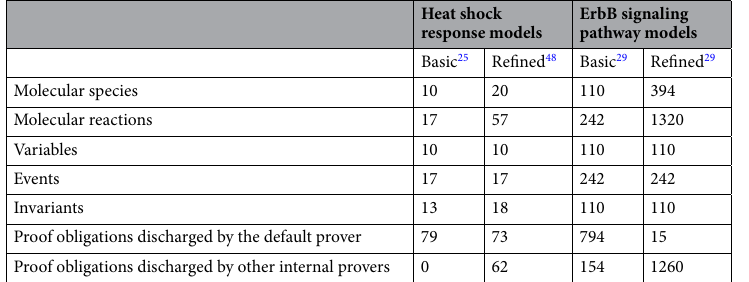
Table 5. The heat shock response and the ErbB models statistics. The number of variables and events is the same for the basic and the refined model. Some of the proof obligations of the refined model required another internal theorem prover than the default one to get them automatically